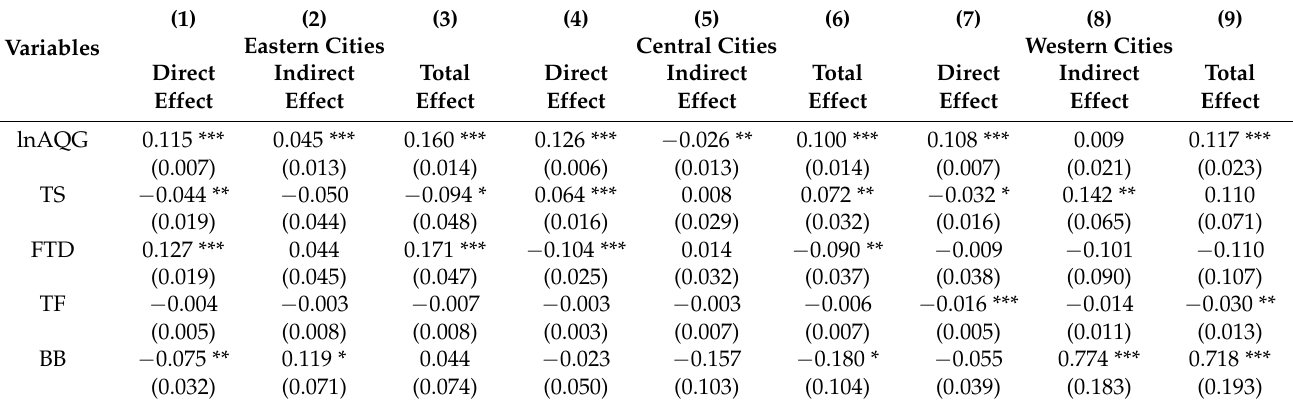
Table 6. Decomposition effect of different